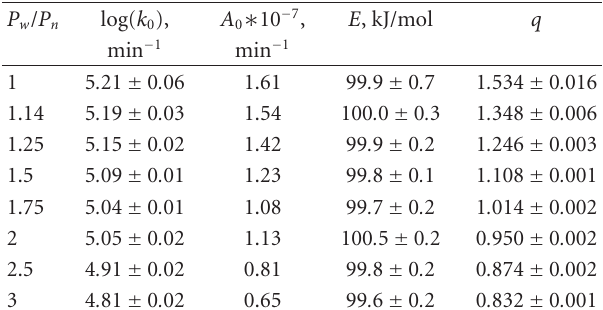
Table 1: Estimations of the Avrami equation parameters for arrays with the initial degree of polymerization equal 100 at isothermal depolymerization.